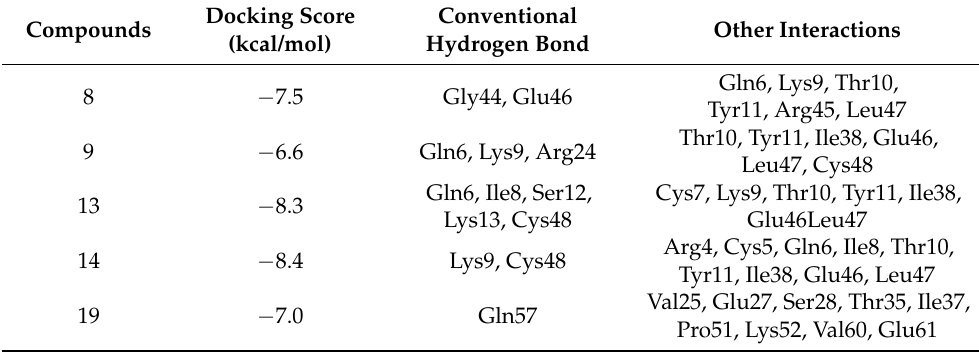
Figure 7. Binding poses and interactions between binding sites of the IL-8 receptor with respect to ligands (compounds 8 ( A ), 9 ( B ), 13 ( C ), 14 ( D ), and 19 ( E )). Table 2. Binding energies and interactions of active compounds against IL-8 production docked into active sites of the IL-8 protein.